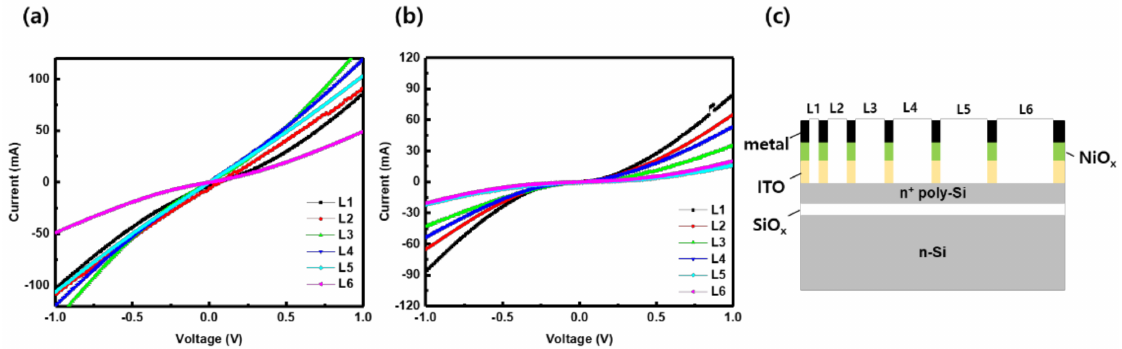
Figure 3. Dark I-V characteristics of Au/NiO x /ITO/n + poly-Si structure: ( a ) with annealing; ( b ) with- out annealing; ( c ) test sample structure. Transmission line measurement (TLM) structure with ~1.2 nm SiO x ; ~300 nm n + poly-Si continuous layers with ITO/NiO x /metal spacing of 0.2, 0.4, 0.8, 1.2, 2.0, and 3.8